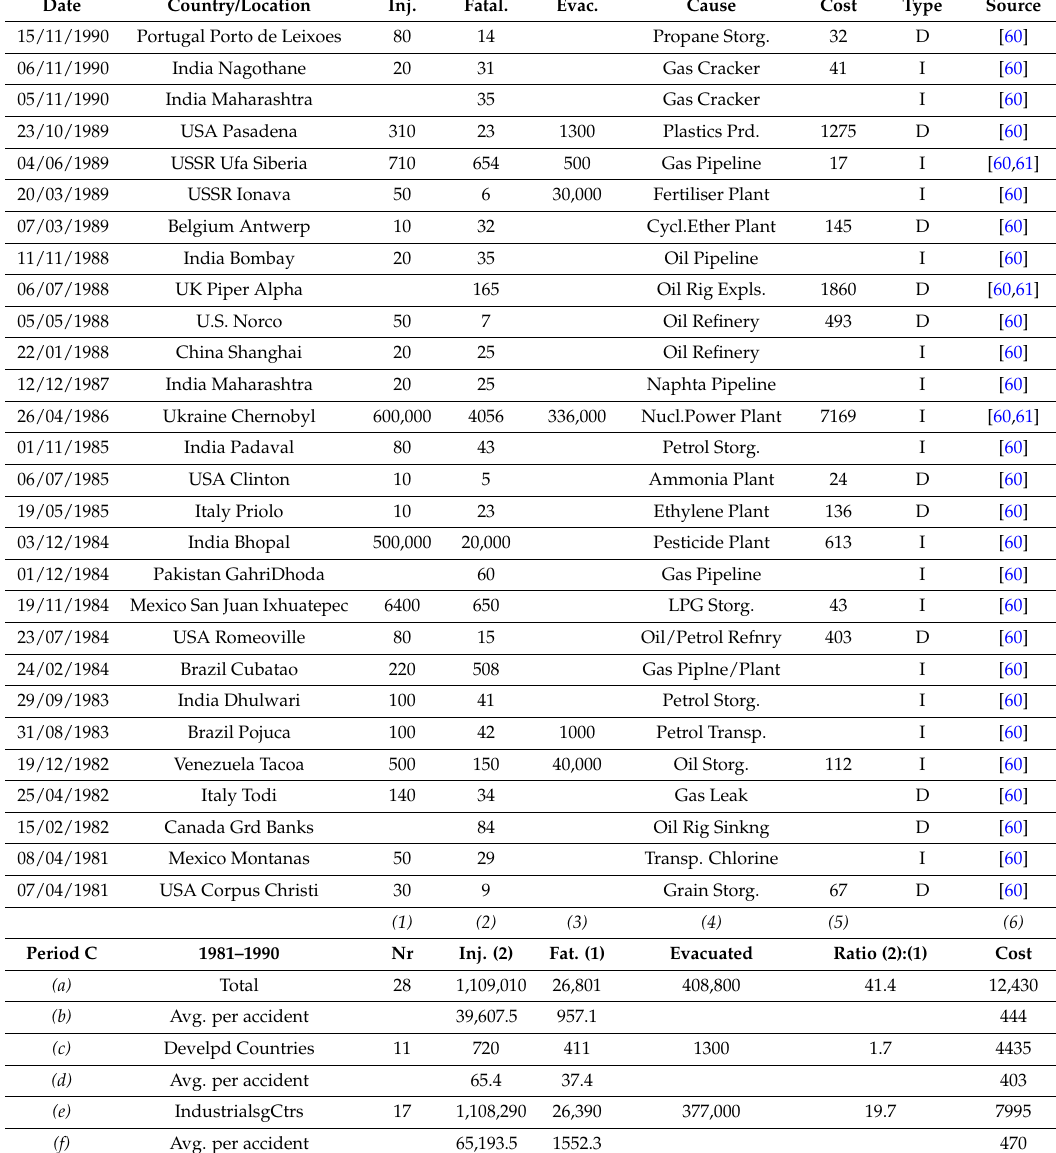
Table 3. Period C,